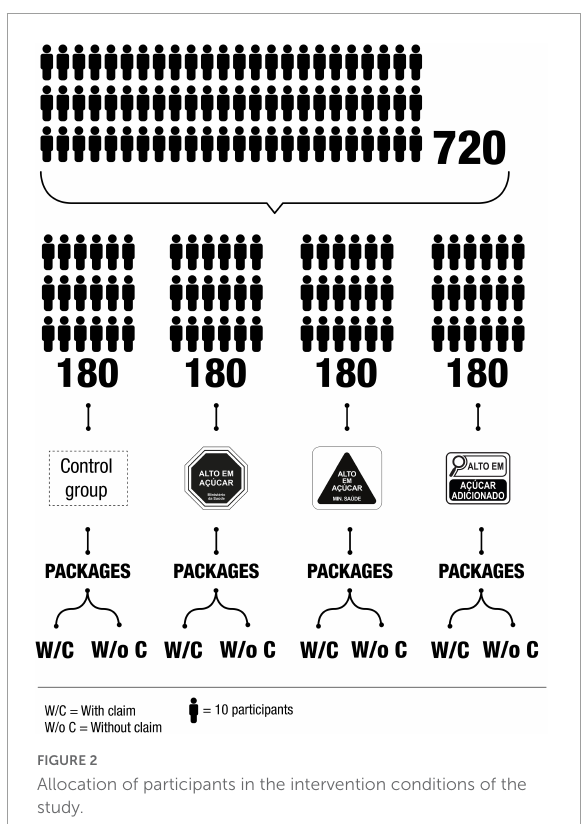
FIGURE2 Allocation of participants in the intervention conditions of the study.